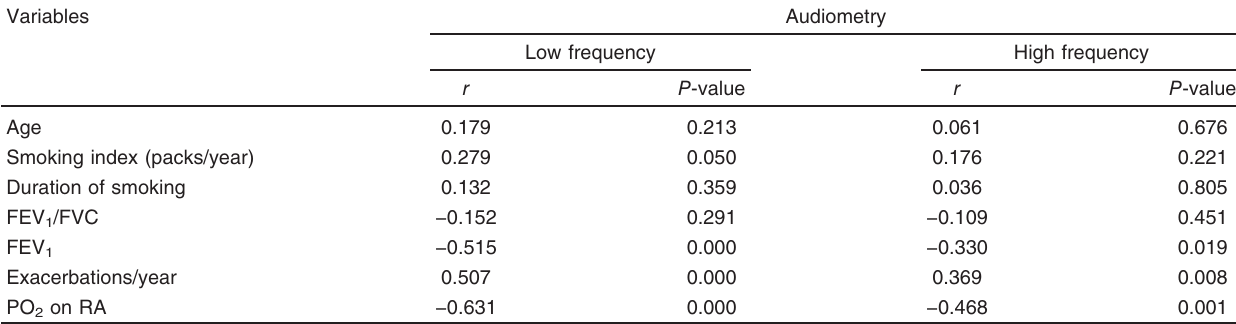
Table 6 Correlation of audiometry and tympanometry with several variables in chronic obstructive pulmonary disease